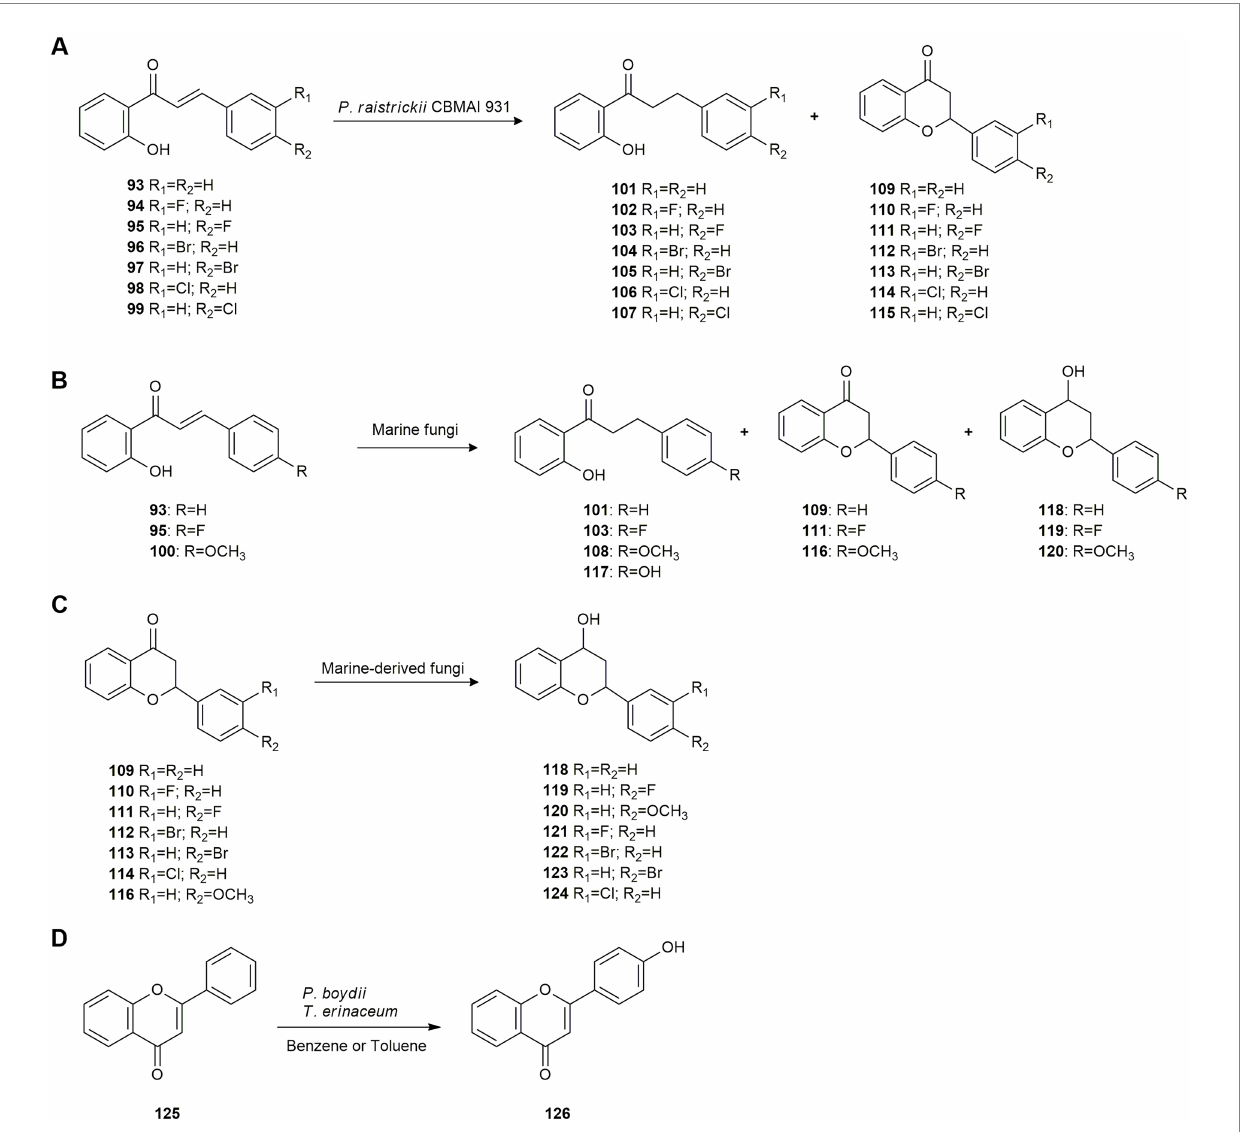
FIGURE 5 Polyketide biotransformations. (A) Hydrogenation of halogenated 2 ′ -hydroxychalcones 93–99 by Penicillium raistrickii CBMAI 935 (de Matos et al., 2019). (B) Biotransformation of 2 ′ -hydroxychalcones 93 , 95 and 100 by marine fungi (de Matos et al., 2021b). (C) Flavone reduction by marine fungi (de Matos et al., 2021a). (D) Regioselective biotransformation of flavone 125 by Pseudallescheria boydii and Trichoderma erinaceum (Kunteng et al.,